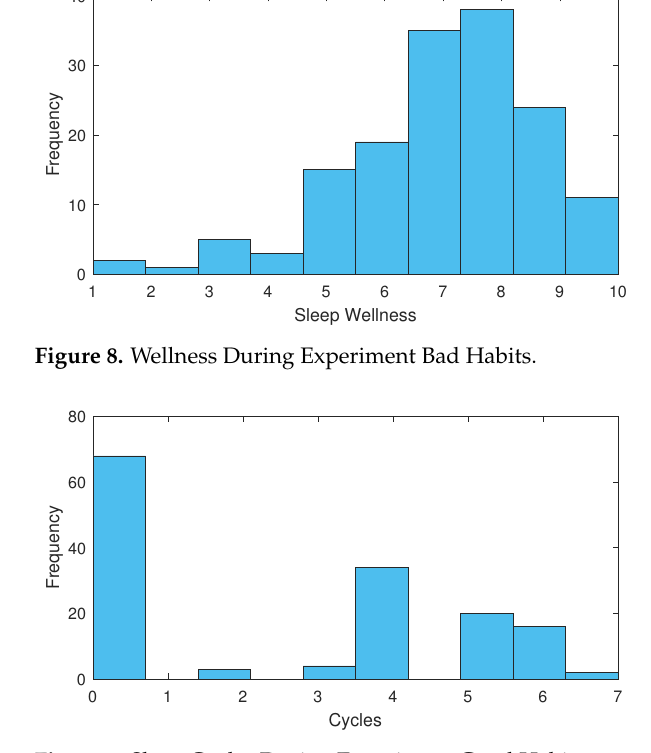
Figure 9. Sleep Cycles During Experiment Good